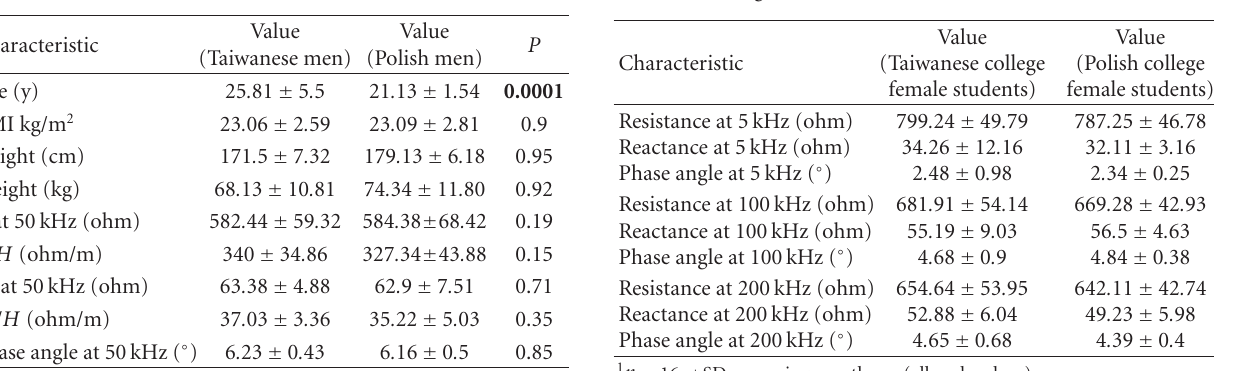
Table 1: Baseline characteristics of the Taiwanese and Polish college male students 1 .